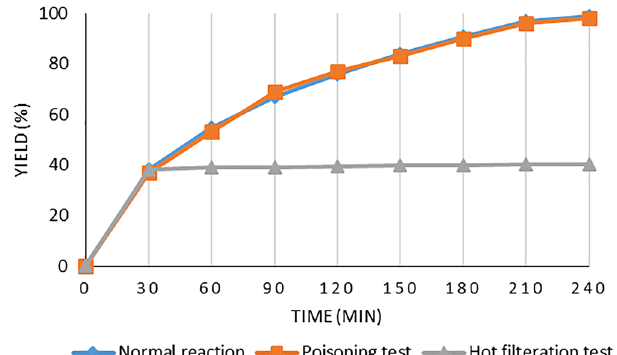
Figure 11. Studies of the heterogeneity of γ-Fe 2 O 3 @MBD/Co-Pd.